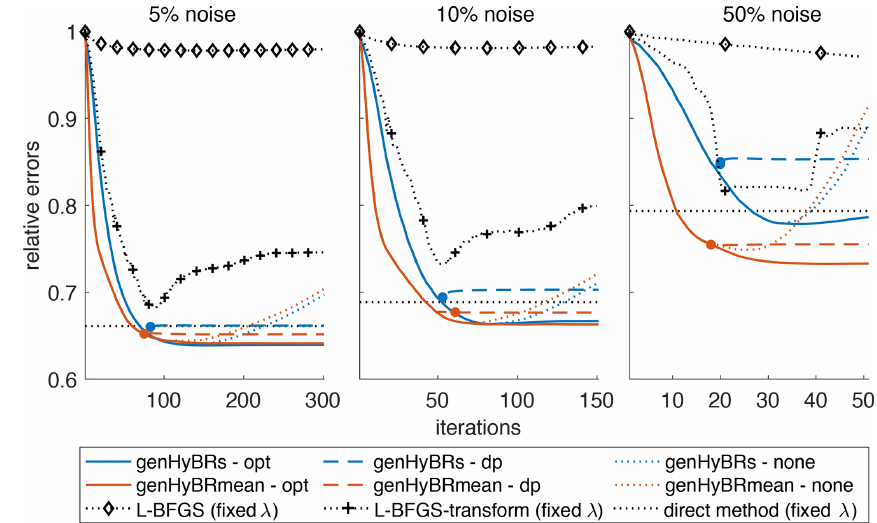
Figure 3. Six-week case study: relative reconstruction error norms per iteration of genHyBRs and genHyBRmean with 5%, 10%, and 50% noise levels. We compare results for the optimal regularization parameter, the automatically selected DP parameter, λ = 0, and the L-BFGS with a fixed regularization parameter ( λ = 1). The filled circle indicates the stopping iteration for the genHyBR methods with DP. In addition, the horizontal line denotes to the relative error for the reconstruction obtained using the direct method. Table 2. Six-week case study: for various noise levels, we provide comparisons of genHyBRs and genHyBRmean (with a DP-selected regularization parameter) to standard direct and iterative methods (with a fixed regularization parameter). We provide the number of iterations, the CPU timing in seconds, and the relative reconstruction error norms for the computed spatiotemporal fluxes denoted by (cid:49) s . Note that, when computing the reconstructions and approximating the posterior variance, additional reorthogonalization is performed, which explains the slight difference in the number of iterations and run times. Noise Recons Recons + uncert Level Methods Selection of λ Iter. Time (s) (cid:49) s Iter. Time (s) (cid:49)